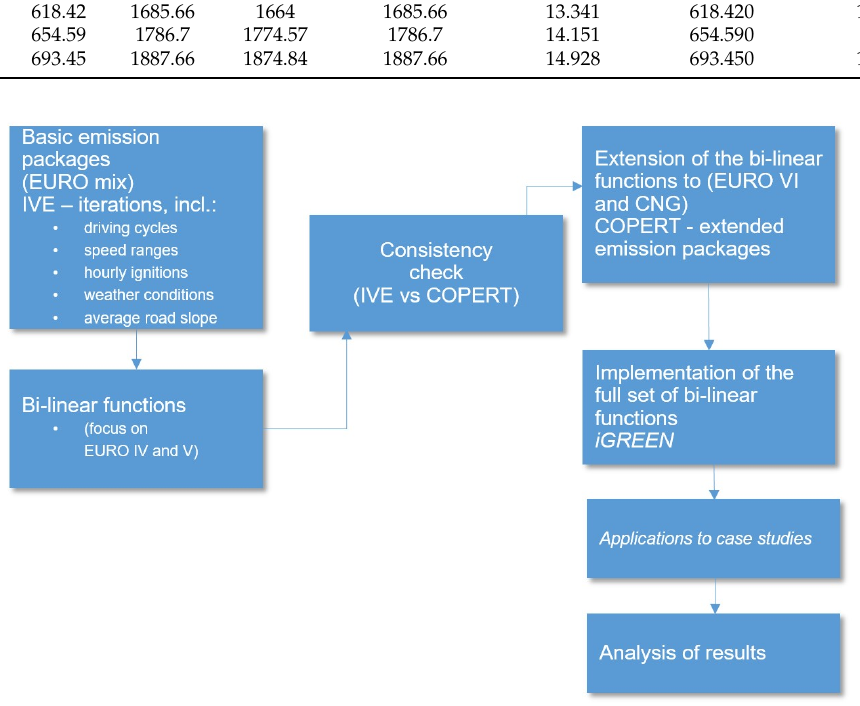
Figure 2. The adopted methodological